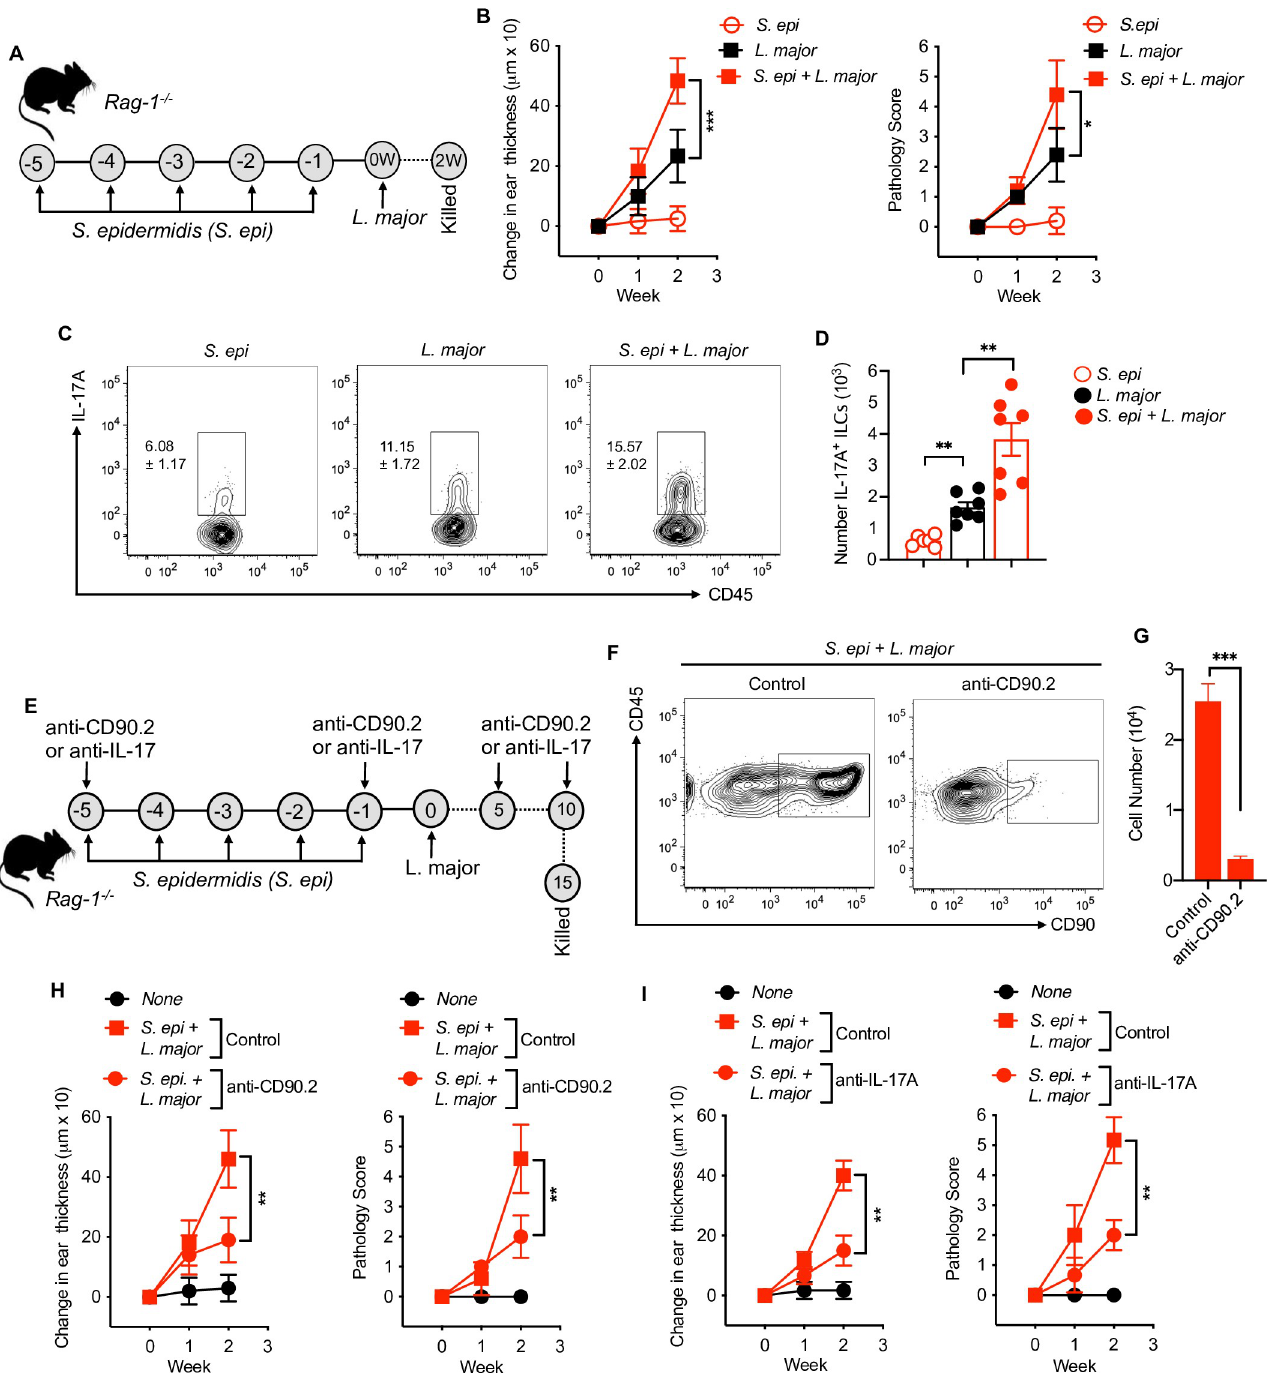
Fig 6. IL-17A + ILCs are sufficient to drive S . epidermidis mediated inflammation. (A) Schematic representation of S . epi and L . major treatment protocol in Rag1 -/- mice. (B) Ear thickness measurement and pathology score in Rag1 -/- mice colonized with S . epi or uncolonized prior to L . major infection at week one and two. (C,D) Percent and number of IL-17A- producing ILCs at week two in Rag1 -/- mice colonized with S . epi or uncolonized prior to L . major infection. (E) Schematic representation of ILC depletion or IL-17 neutralization treatment protocol in Rag1 -/- mice. (F) Representative flow cytometry plot of ILC depletion as identified as CD45 + CD90 + cells in Rag1 -/- mice. (G) Number of CD90 + cells in control and anti-CD90.2 treated mice. (H) Ear thickness measurement and pathology score in Rag1 -/- mice with and without (Control; IgG) ILC depletion in different groups. (I) Ear thickness measurement and pathology score in Rag1 -/- mice with and without (Control; IgG) IL-17A neutralization by anti-IL-17A antibody in different groups. Number within the flow plot show percent of IL-17A + cells with SEM (C). Data are from two experiments with a total of six to seven mice in each group. Statistical comparison within the flow plot is with L . major group. Error bars shows SEM (D,G) or SD (B,H,I). Two-tailed unpaired Student’s t-test with Welch’s correction. � p < 0.05, �� p < 0.01, ��� p < 0.001.